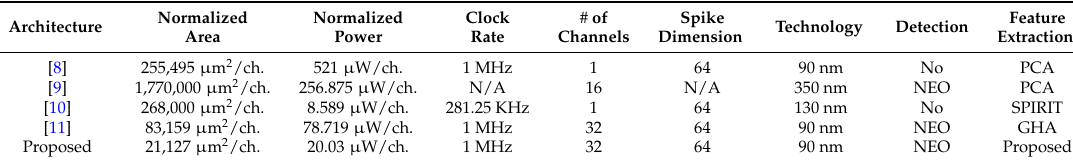
Table 6. The comparisons of various spike sorting